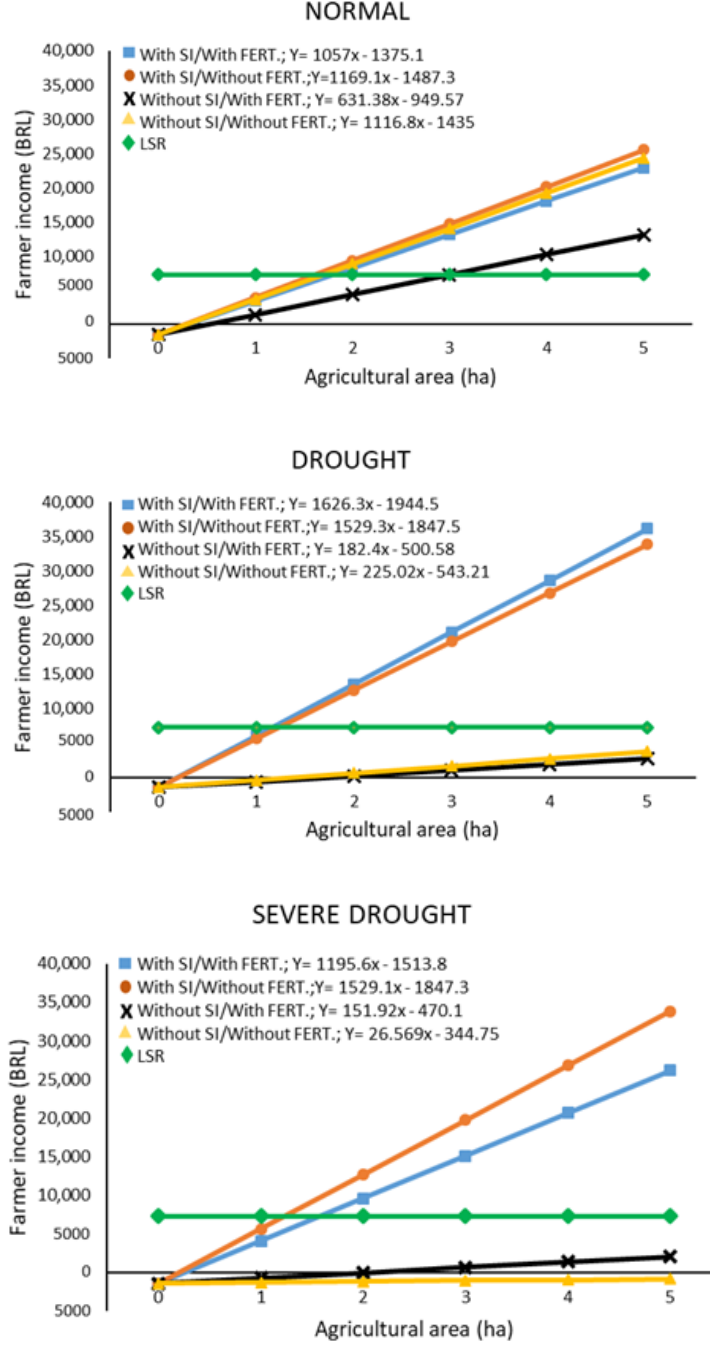
Figure 4. Farmers’ income for the different simulated water scenarios, supplemental irrigation (SI with treated wastewater, and the presence or absence of NPK fertilization, as a function of the area cultivated with BRS 433 cotton. The green line indicates the Level of Social Reproduction (LSR).